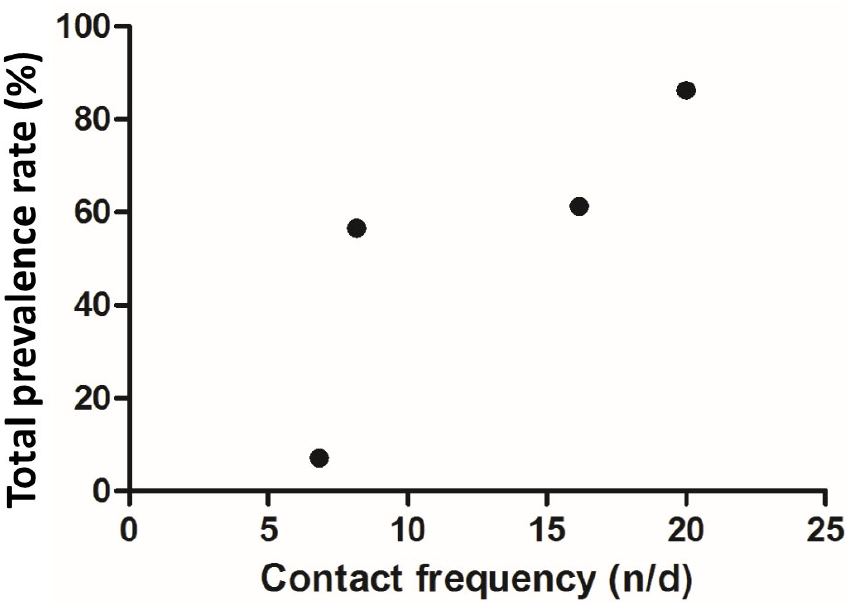
Figure 4. Correlation between the contact frequency and seasonal intestinal parasite prevalence.